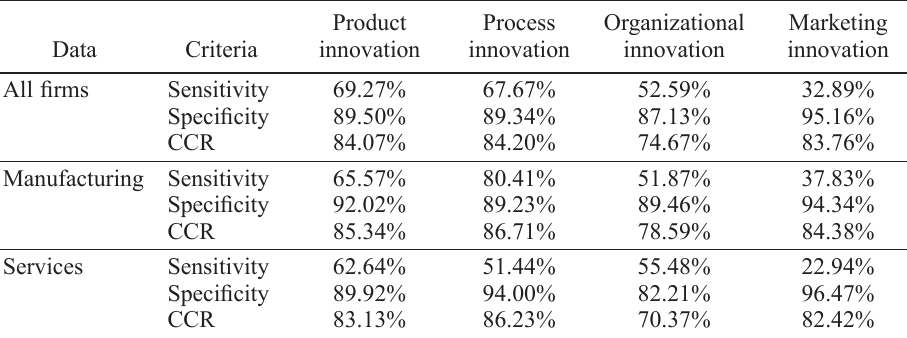
Table 3. Performance evaluation